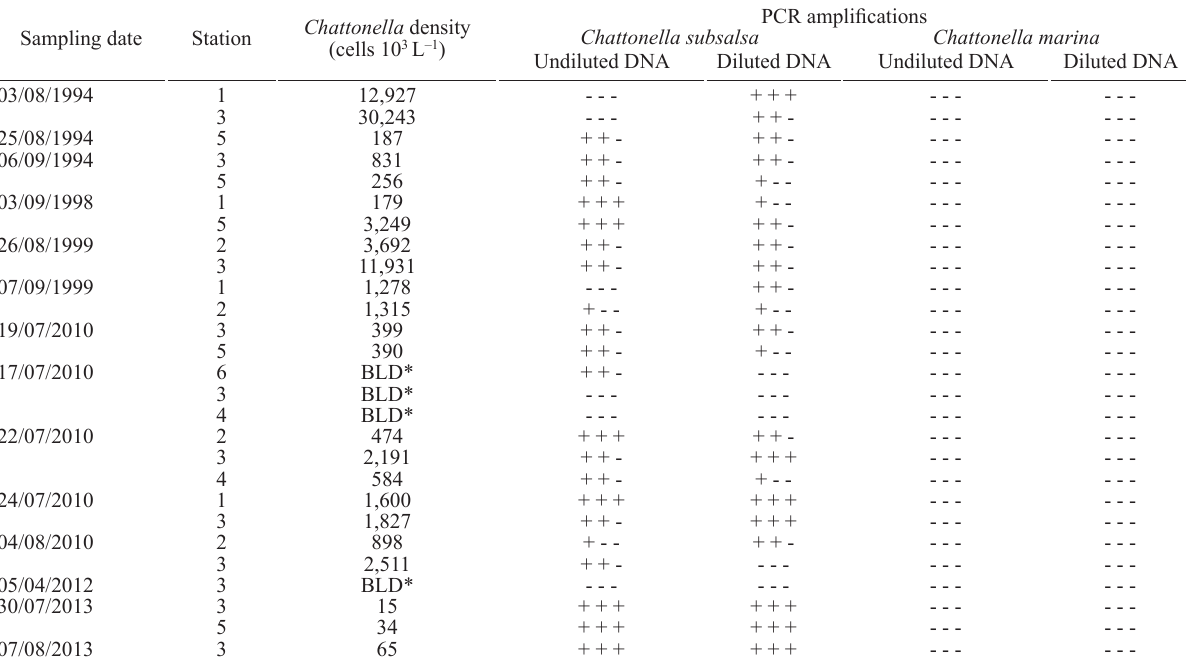
Table 1. – List of analysed samples, Chattonella densities and PCR amplification assay results. +, positive amplification; –, negative amplifi- cation. * BLD, below the detection limit of <10 cells L –1